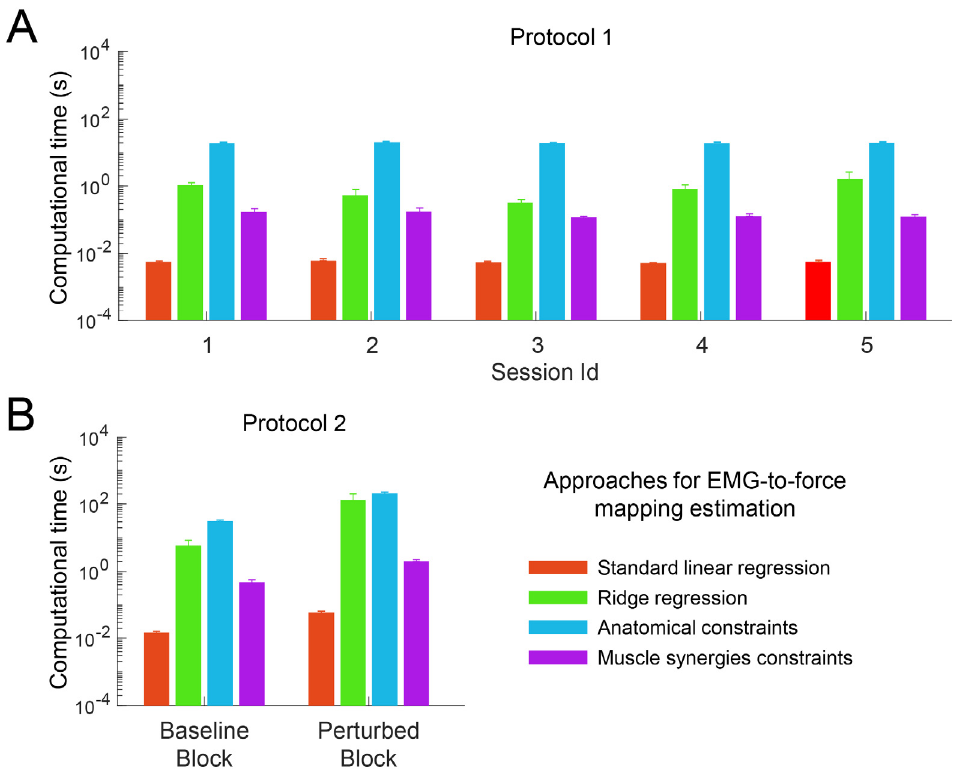
Figure 3. Computational time, i.e., the time required to calculate the EMG-to-force mapping with different approaches (color-coded, mean ± SE across participants). The y axis is in logarithmic scale. ( A ). results got from data collected during protocol 1. ( B ). results got from data collected during protocol 2.